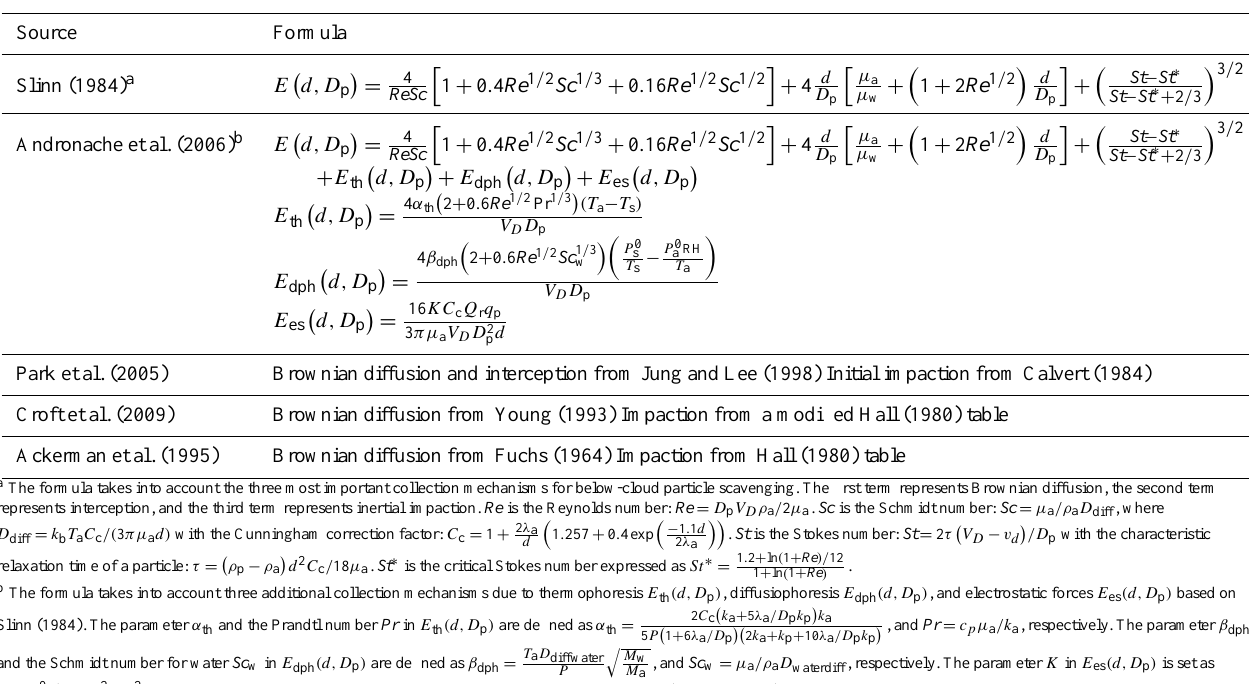
Table 1. List of semi-empirical formulas for raindrop–aerosol particle collection efficiency E(d,D p ) . Symbols used in Tables 1–9 and their units are defined in Table E1 in Appendix